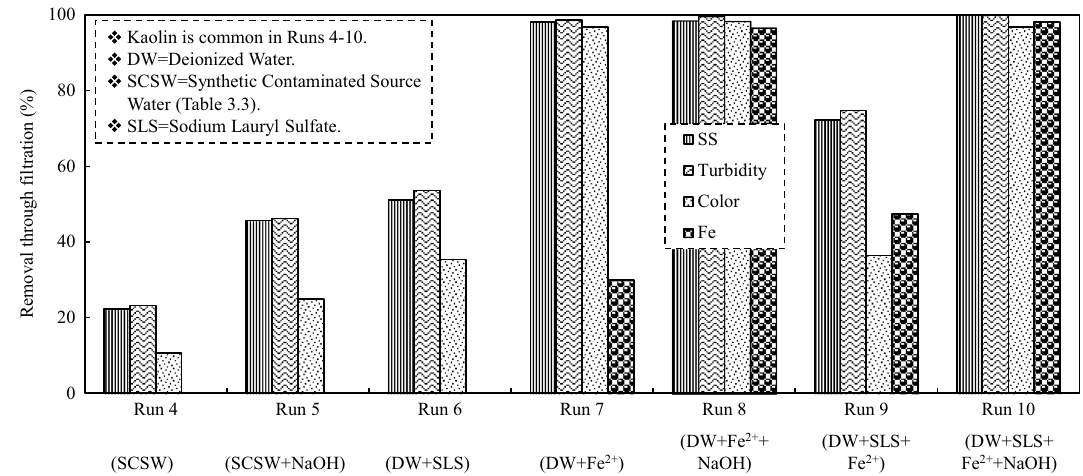
Fig. 7 SS, turbidity, color, and Fe removal efficiency of Runs 4–10 at the filtration hydraulic loading of 283 L/m 2 /min, with the applied terminal voltage of + 1.0 V